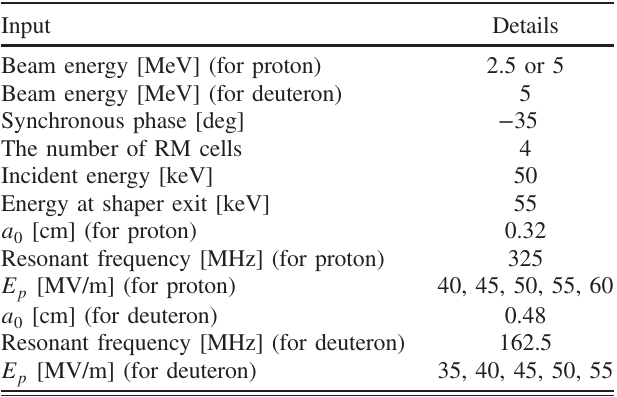
TABLE V. Input parameter list for RFQGen for proton/deu- teron acceleration simulation. Actually, the peak surface E-field E a p and the minimum aperture 0 determined from the RFQGen software were slightly lower than the values of the input parameters.